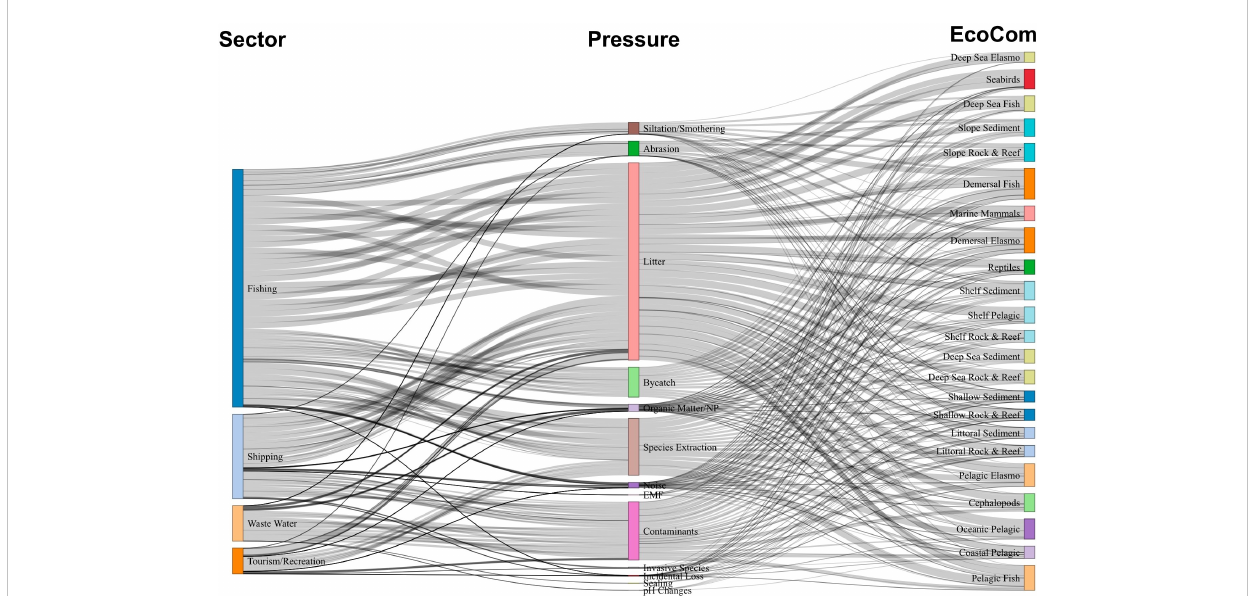
FIGURE 3 Sankey diagram of pathways among principal sectors (left), the pressures (middle) and the ecological components (EcoCom) of impacts (right). The width of lines represents the sum impact risk score (product of overlap, frequency, and degree of impact). EMF, electromagnetic fi eld; Elasmo,